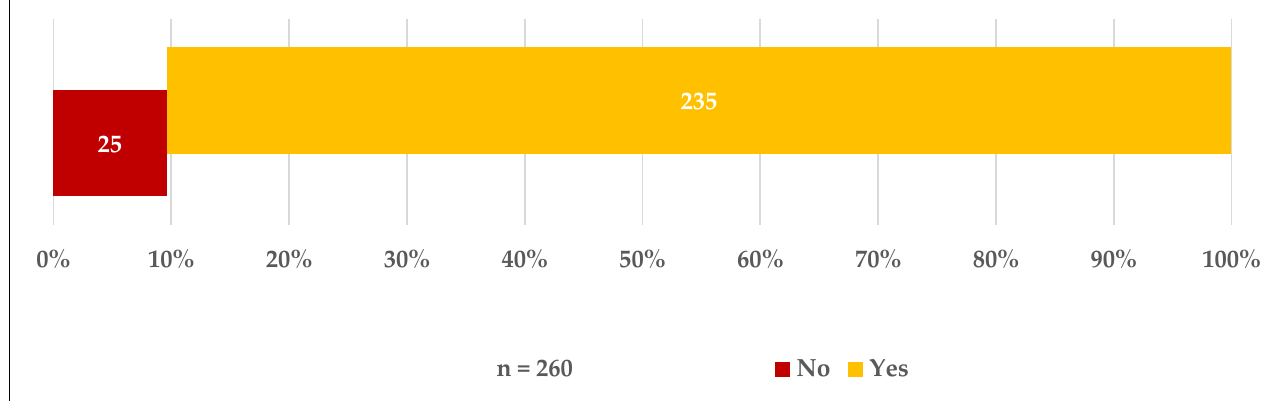
Figure 2. Acceptance to receive the COVID-19 vaccine.